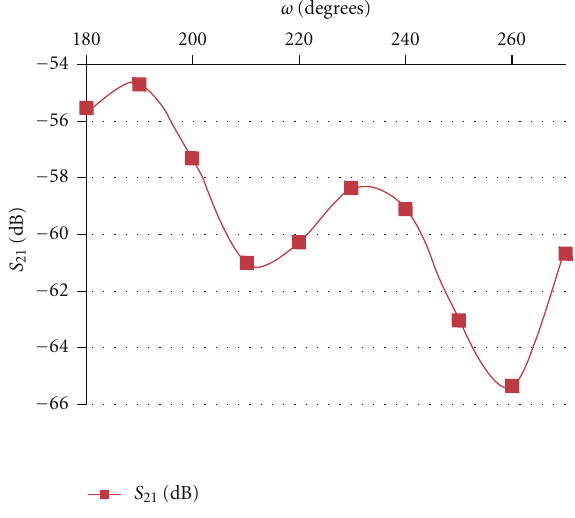
Figure 20: S 21 as a function of angle ω for configuration 2.